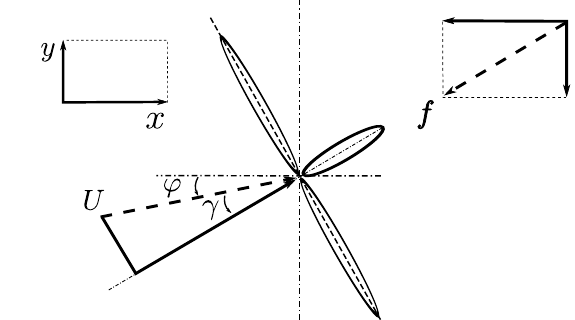
Figure 4. Schematic representation of a turbine with yaw angle γ n and flow velocity U = ( [ u ( x n ,y n ) ] 2 +[ v ( x n ,y n ) ] 2 ) 1 / 2 at the rotor. Figure adapted from Jiménez et al. (2010).